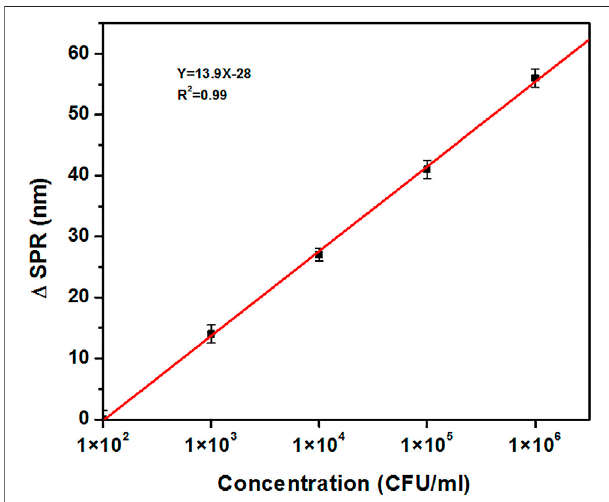
FIGURE 6 | The calibration curve of H-1-AuNPs for concentrations of 1×10 2 , 1×10 3 , 1×10 4 , 1×10 5 , and 1 × 10 6 CFU/ml of M1 GAS in terms of variations in the red-shift. Calibration curve shows a linear